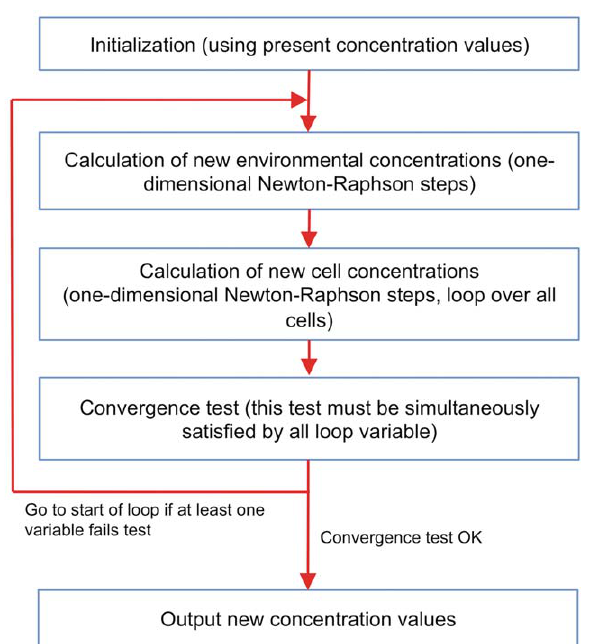
Figure 10. Functional blocks of the C ++ method that computes metabolic and extracellular variables. This part performs a loop that computes the solution of the nonlinear equations found in the implicit Euler integration step [29] (see also Text S1). Although the number of variables can be quite large (more than 10 7 variables), convergence is fast, because the initial concentration values are invariably very close to the final ones.